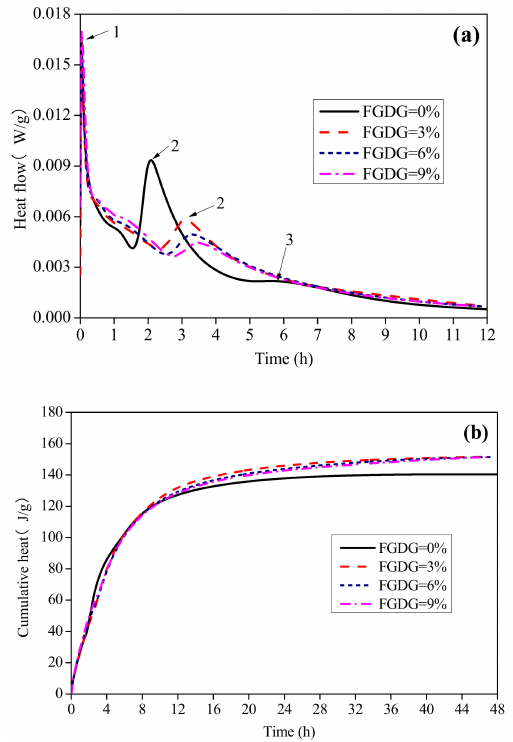
Figure 2. Hydration heat of CSAC-GGBFS mixtures with different FGDG content. ( a ) Heat flow, ( b ) cumulative